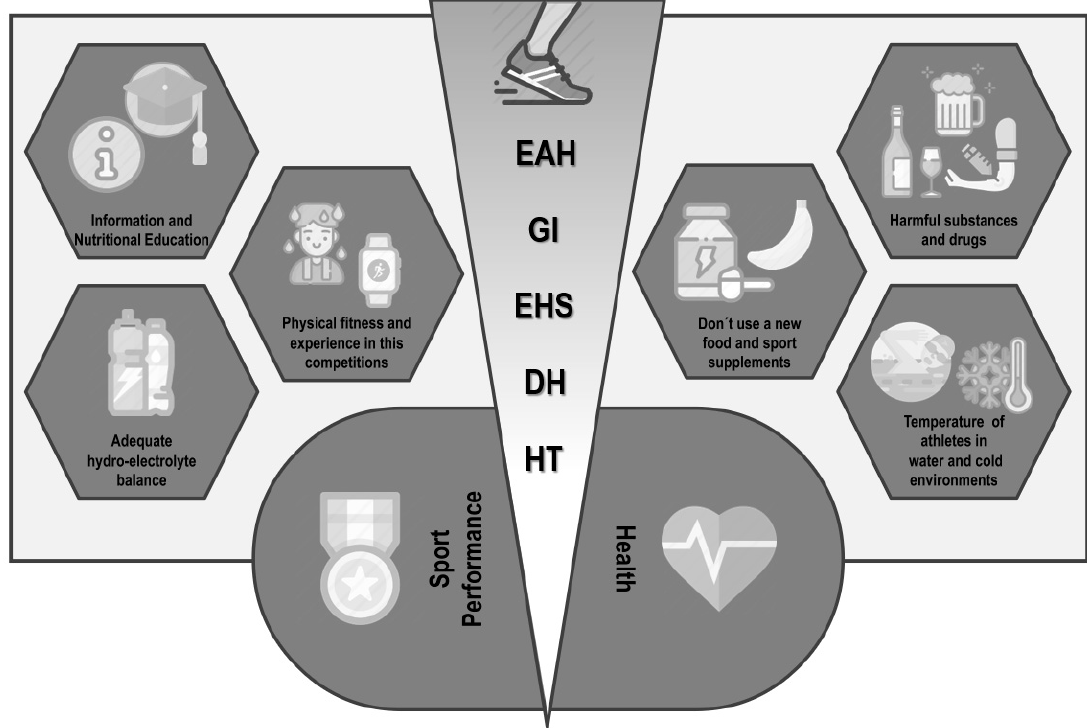
Figure 2. Nutrition-related adverse outcomes in endurance and ultra-endurance sports: key aspects to be considered. EAH: exercise-associated hyponatremia; GI: gastrointestinal problems; EHS: heat stroke by exertion; DH: dehydration; HT: hypothermia